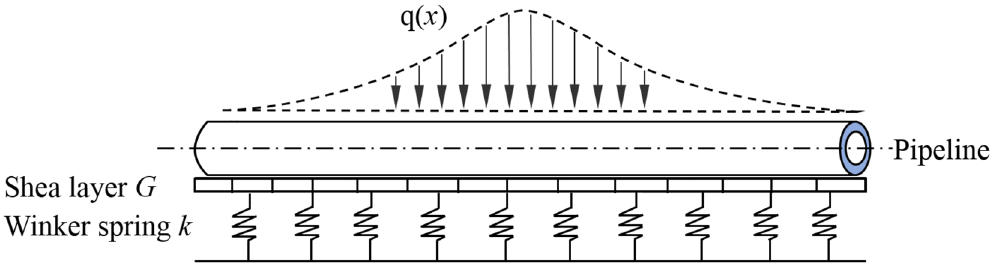
Figure 2. Pasternak foundation model.